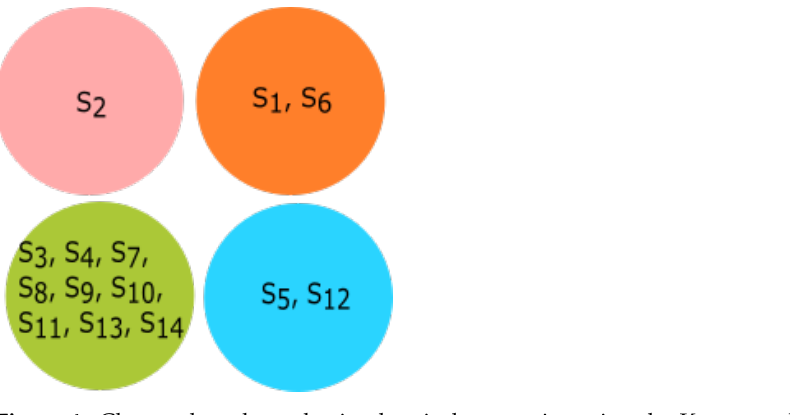
Figure 4. Clusters based on physicochemical properties using the K-means algorithm. Here, S i indicates the species name as specified in Table 1.